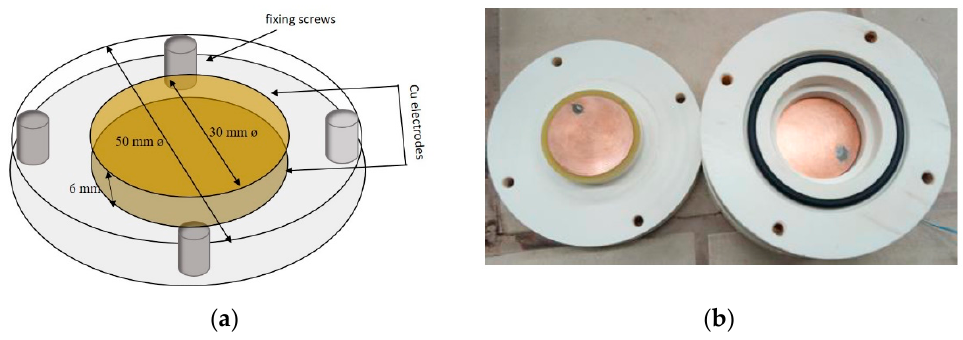
Figure 1. Sketch ( a ) and picture ( b ) of the measuring cell [47].